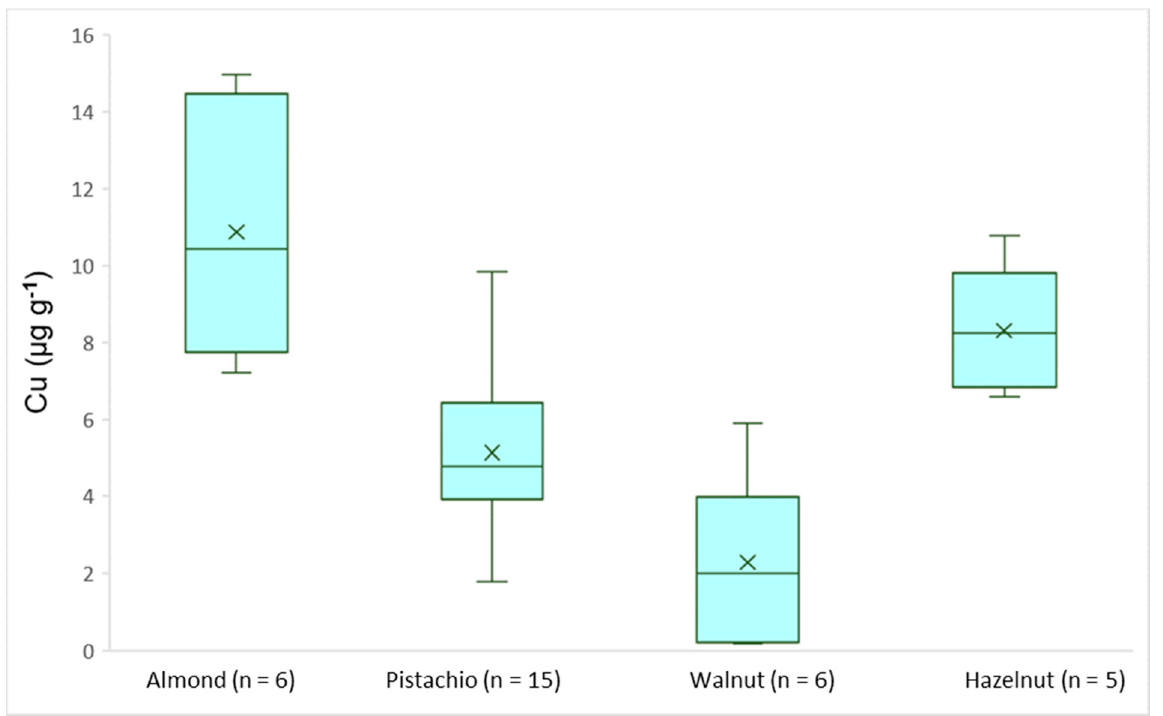
Figure 6. Box and Whisker plot for the concentrations of copper among different nut species. As far as manganese concentration was concerned, the average concentration in almonds was 17.5 µ g g − 1 followed by 14.1 µ g g − 1 in walnuts, 13.1 µ g g − 1 in hazelnuts and 11.1 µ g g − 1 in pistachios (Figure 7). The ANOVA test showed a significant statistical difference in manganese concentrations among the nut species ( p = 0.004).